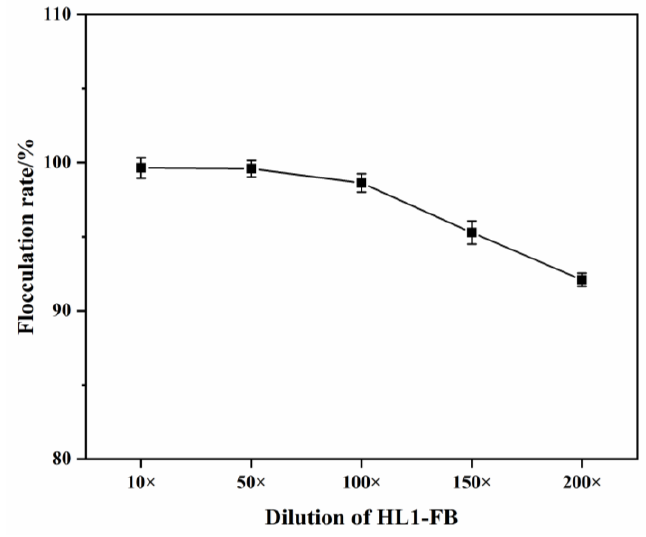
Figure 3. Flocculation rate of different dosage of HL1-FB .